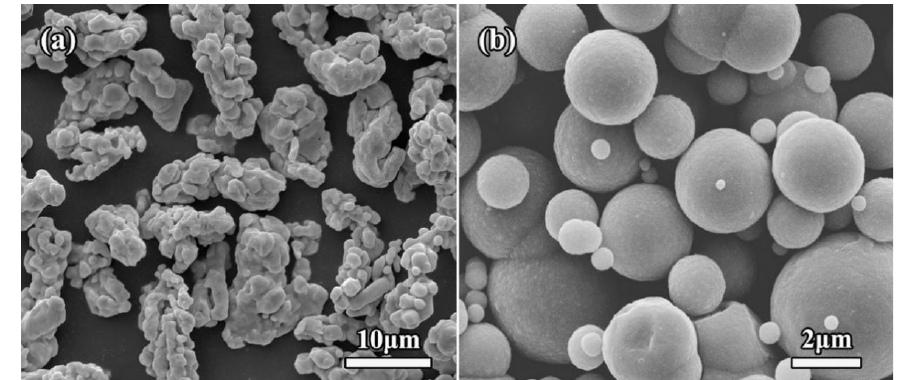
Figure 14. SEM micrographs of the original Cu ( a ) and Fe ( b ) powders.